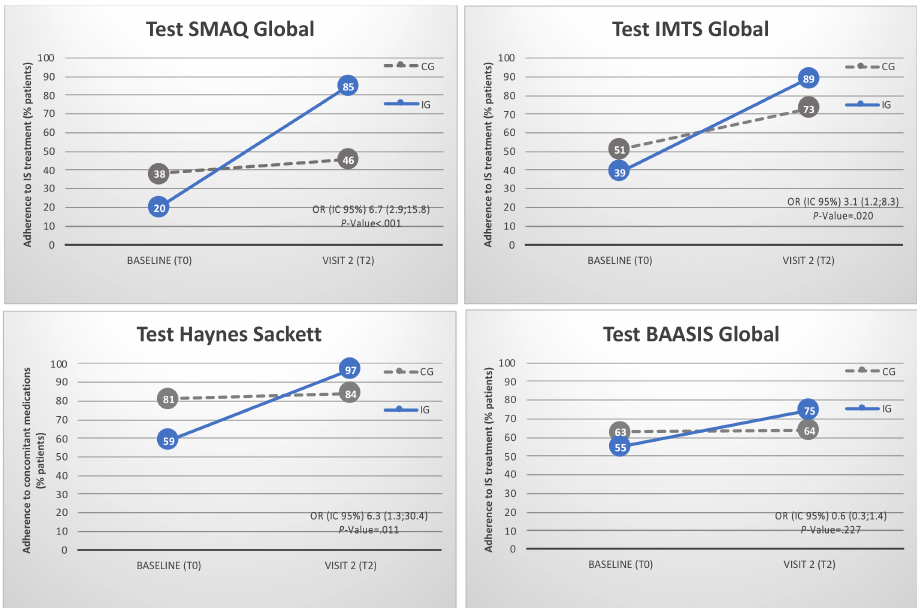
Figure 5. Adherence to immunosuppressive treatment according to the SMAQ interview ques- tionnaire, the Timing of medication taking (IMTS test), the Global BAASIS patient self-reported questionnaire and the Haynes–Sackett adherence to concomitant medication scale. Scheduled in- clinic visits were T0 (baseline at study inclusion) and T2 (at least 12 months after inclusion). Control Group (CG) was based on (i) in-clinic visits at the Hospital outpatient department and (ii) multidis- ciplinary team including the pharmacist. Intervention Group (IG, the mHeart Strategy) was based on (i) in-clinic visits at the Hospital outpatient department, (ii) multidisciplinary team including the pharmacist and (iii) the mHeart mobile application for remote interaction with the pharmacist. A CV > 30% was observed in 49% of recipients (47% CG; 41% IG, p -value =